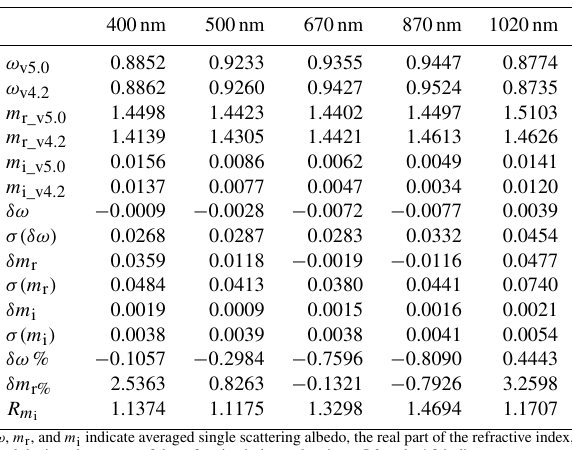
Table 3. Averaged single scattering albedo and refractive index in SKYRAD V5.0 and V4.2, and the absolute and percentage differ- ences between the two versions at the Qionghai site during Febru-